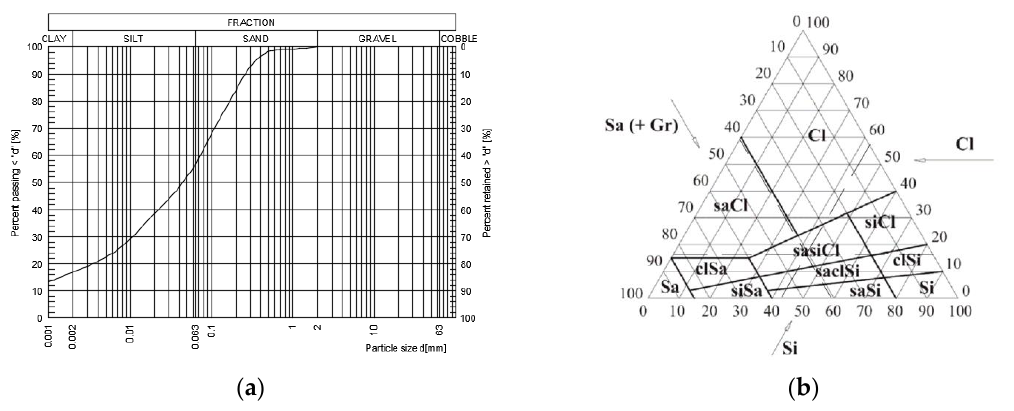
Figure 1. Soil classification ( a ); Grain size distribution curve; ( b ) Application of Feret’s triangle to